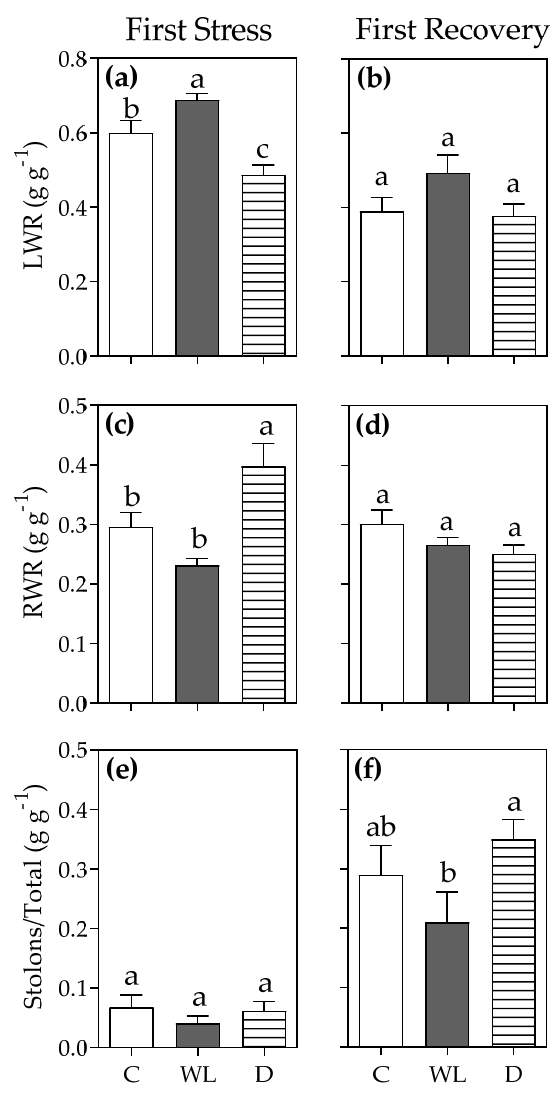
Figure 2. Leaf weight ratio (LWR; ( a , b )), root weight ratio (RWR; ( c , d )), and stolon/total ratio ( e , f ) of Chloris gayana plants subjected during 13 days to control conditions (C, white bars), waterlogging (WL, grey bars), or drought (D, striped bars) in the first stress round ( a , c , e ), and the subsequent 15-day recovery phase ( b , d , f ). Values are means ± e.e. (n = 8). Different letters indicate differences between treatments ( p < 0.05).